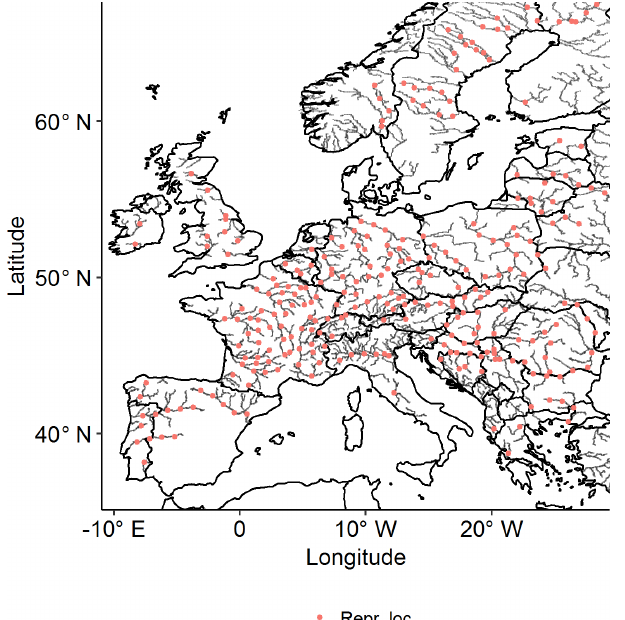
Figure 2. The network of major European rivers and a subset of 298 representative locations.